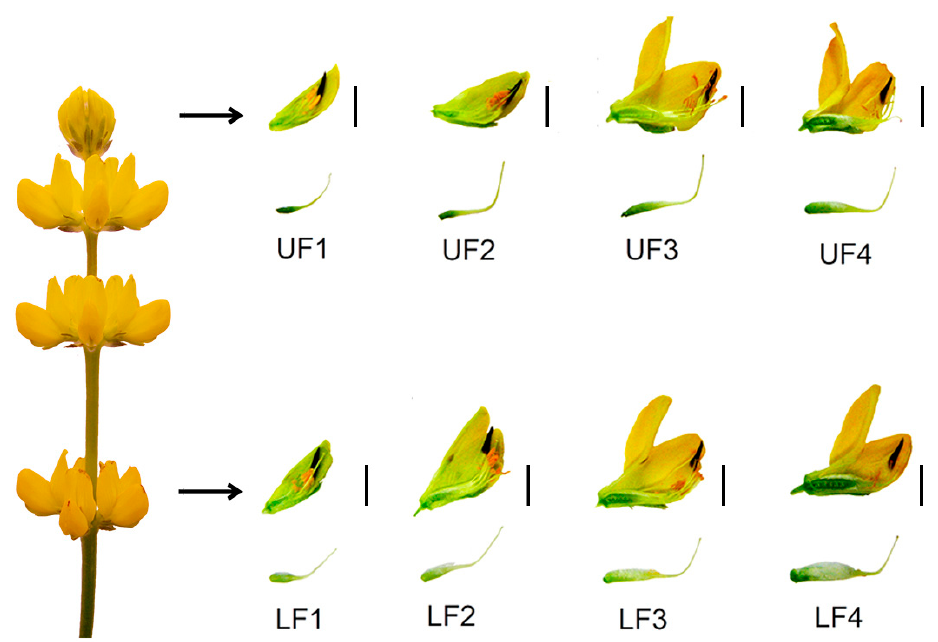
Figure 1. Development of Lupinus luteus flowers from the upper and lower part of the raceme. An isolated pistil from a given developmental stage is shown under each flower. LF—lower flower, UF—upper flower. Bar 5 mm.